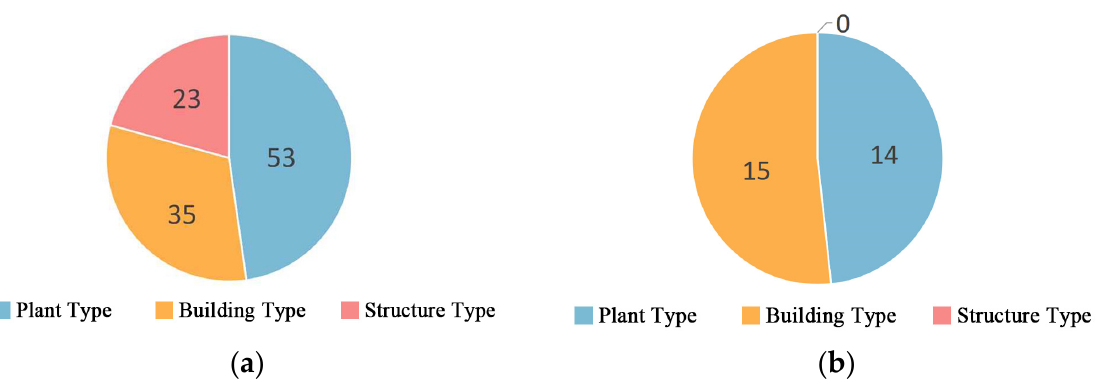
Figure 9. ( a ) Statistical map of the resource types of industrial heritage in Tianjin; ( b ) statistical map of the current status of reuse of industrial heritage resource types in Tianjin.